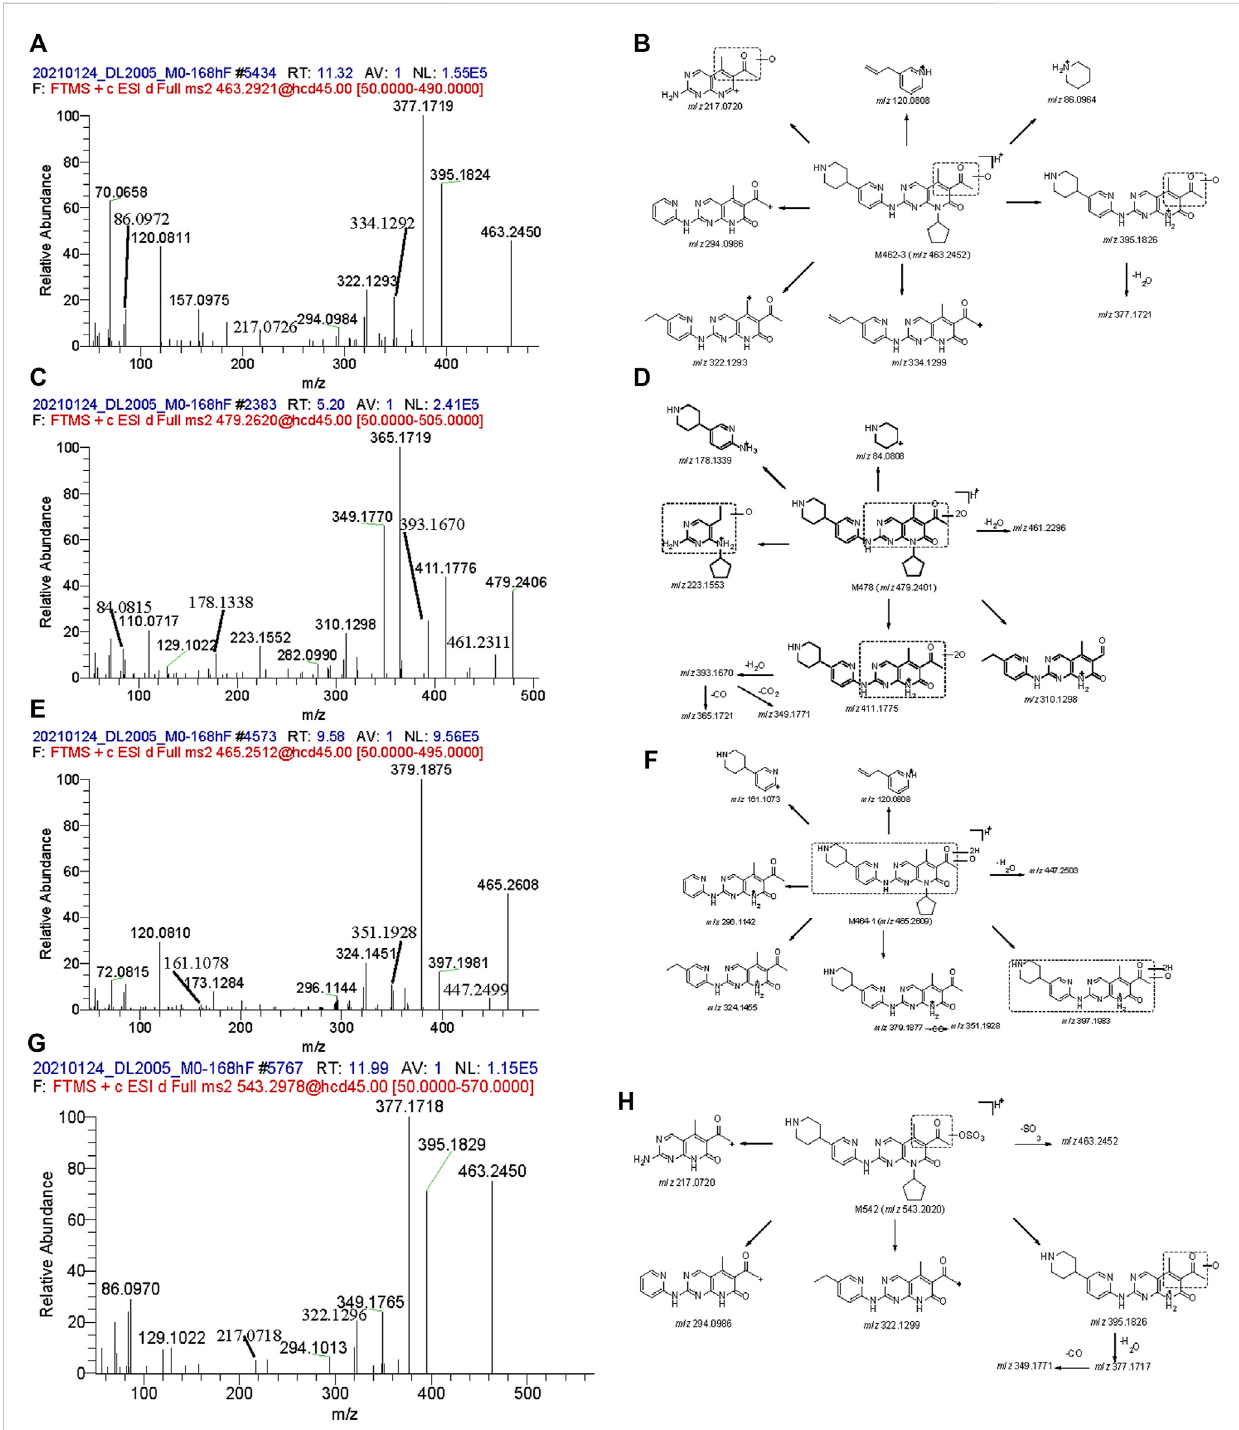
FIGURE 4 Mass spectra and the proposed fragmentation pro fi les of metabolites: M462-3 (A, B) , M478 (C, D) , M464-1 (E, F) , and M542 (G, H) in ESI (+).